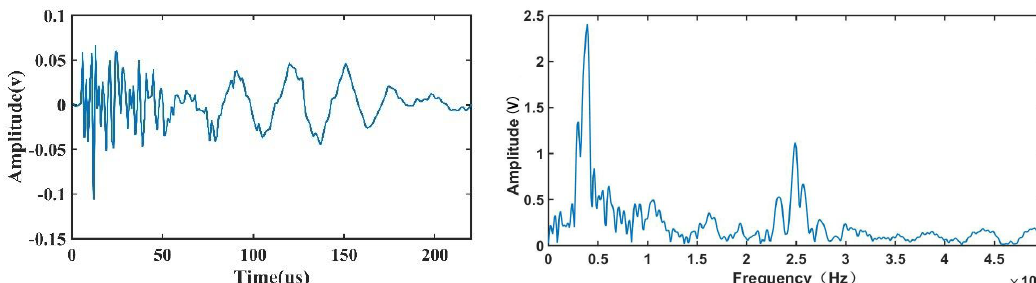
Figure 16: Typical waveform and FFT spectrogram for class4